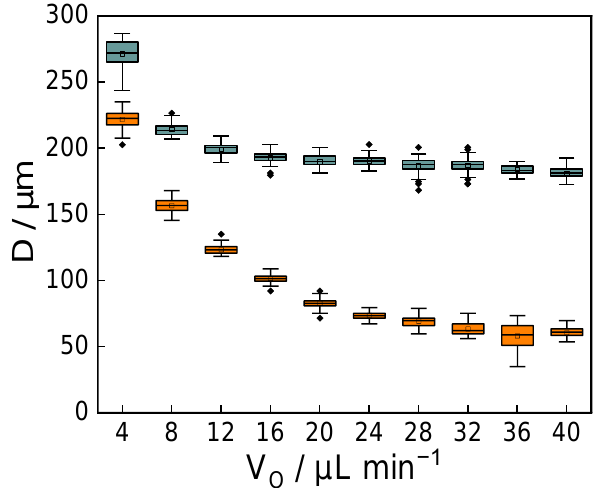
Figure 5. A box plot showing the dependence of the diameter of microdroplets on V O . The volume flow rate of the dispersed phase was fixed to 1 μL min −1 . Dispersed phase: (Orange) PBS, (Blue) 10 % PEG solution. N = 50.